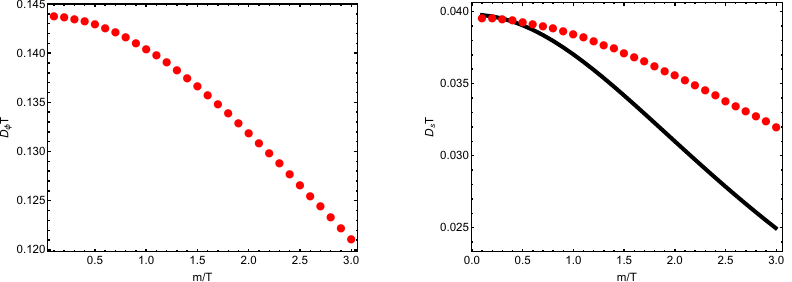
Figure 12 . The sound (red) and crystal di(cid:11)usion (green) modes present in the longitudinal spec- trum of the (cid:13)uid model (4.1) for m=T = 0 : 470. Left: the real part of the modes. The white dashed line is the hydrodynamic formula (4.6) with speed (4.9). Right: the white dashed line is the hydrodynamic formula (4.6) with di(cid:11)usion constant (4.10). The black dashed line is the (cid:12)t for the crystal di(cid:11)usion mode.